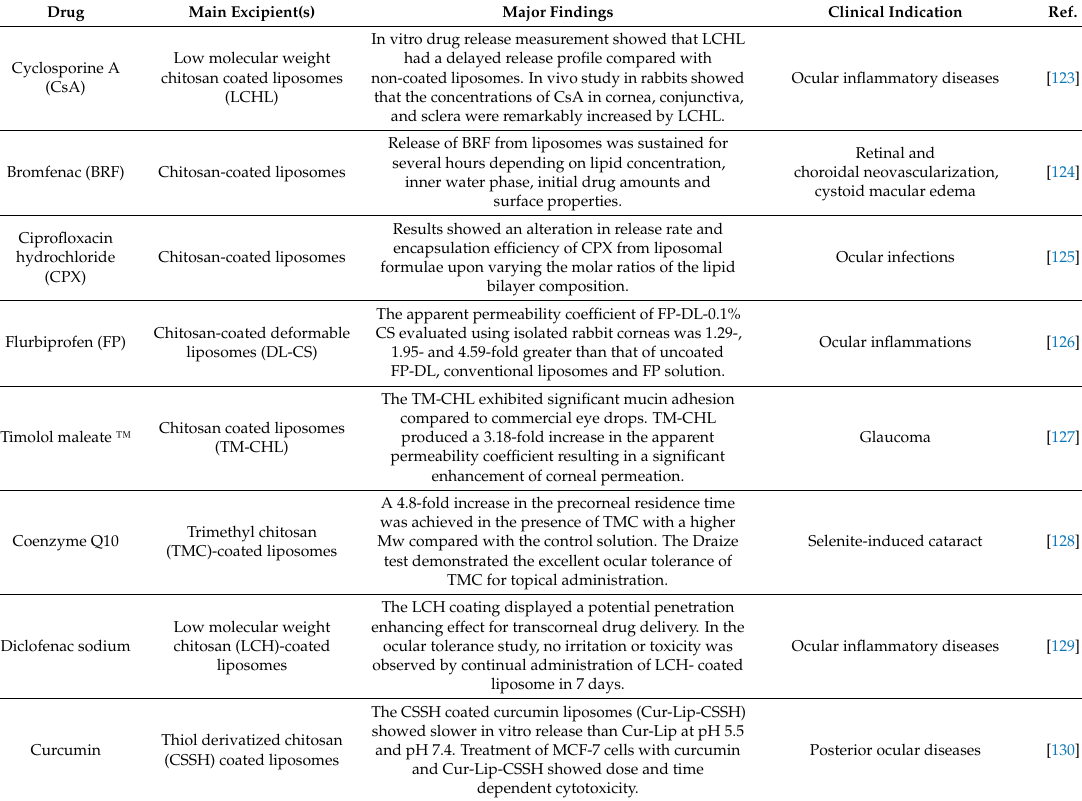
Table 2. Chitosan-based liposomes for ocular drug